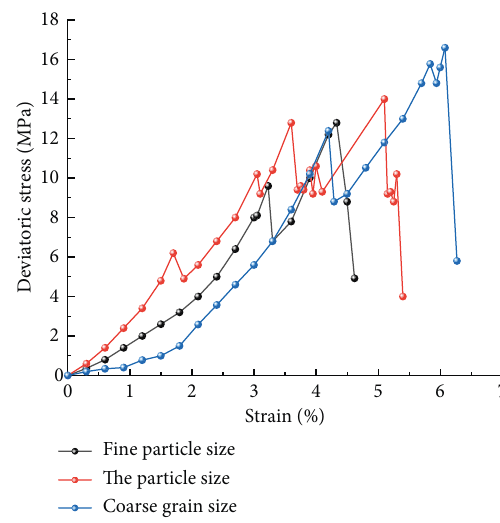
Figure 7: Stress evolution of mudstone specimens with different joint plane roughness.